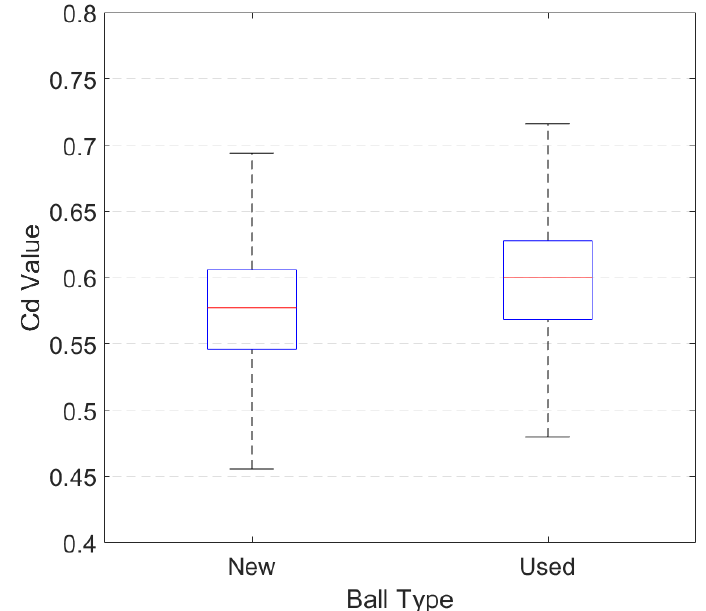
Figure 3. The distribution of Cd values for 4651 serves made with new balls and 4573 serves made with used balls. Outliers, which were further than 2.7 standard deviations from the mean, have not been displayed (129 for new balls and 191 for used